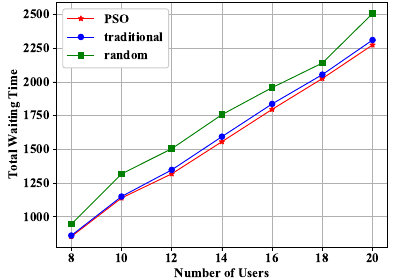
Figure 5. The total waiting time with a different number of services in a single-service composition.